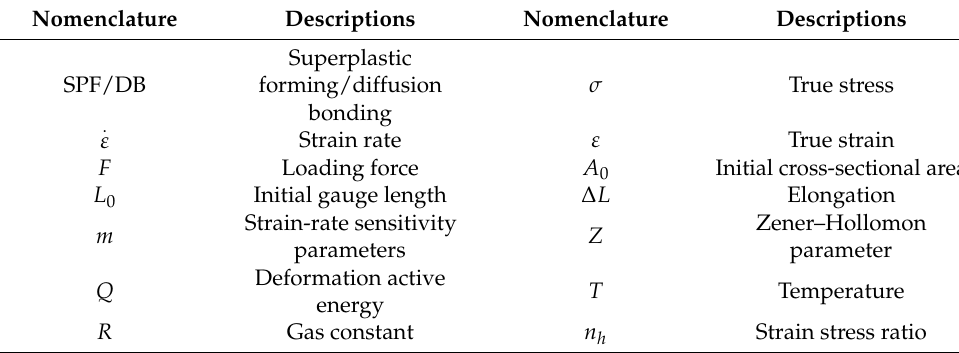
Figure 1. Schematic diagram of the sandwich structure used for FEM analysis. Table 1. Summary of nomenclature. Table 1. Summary of